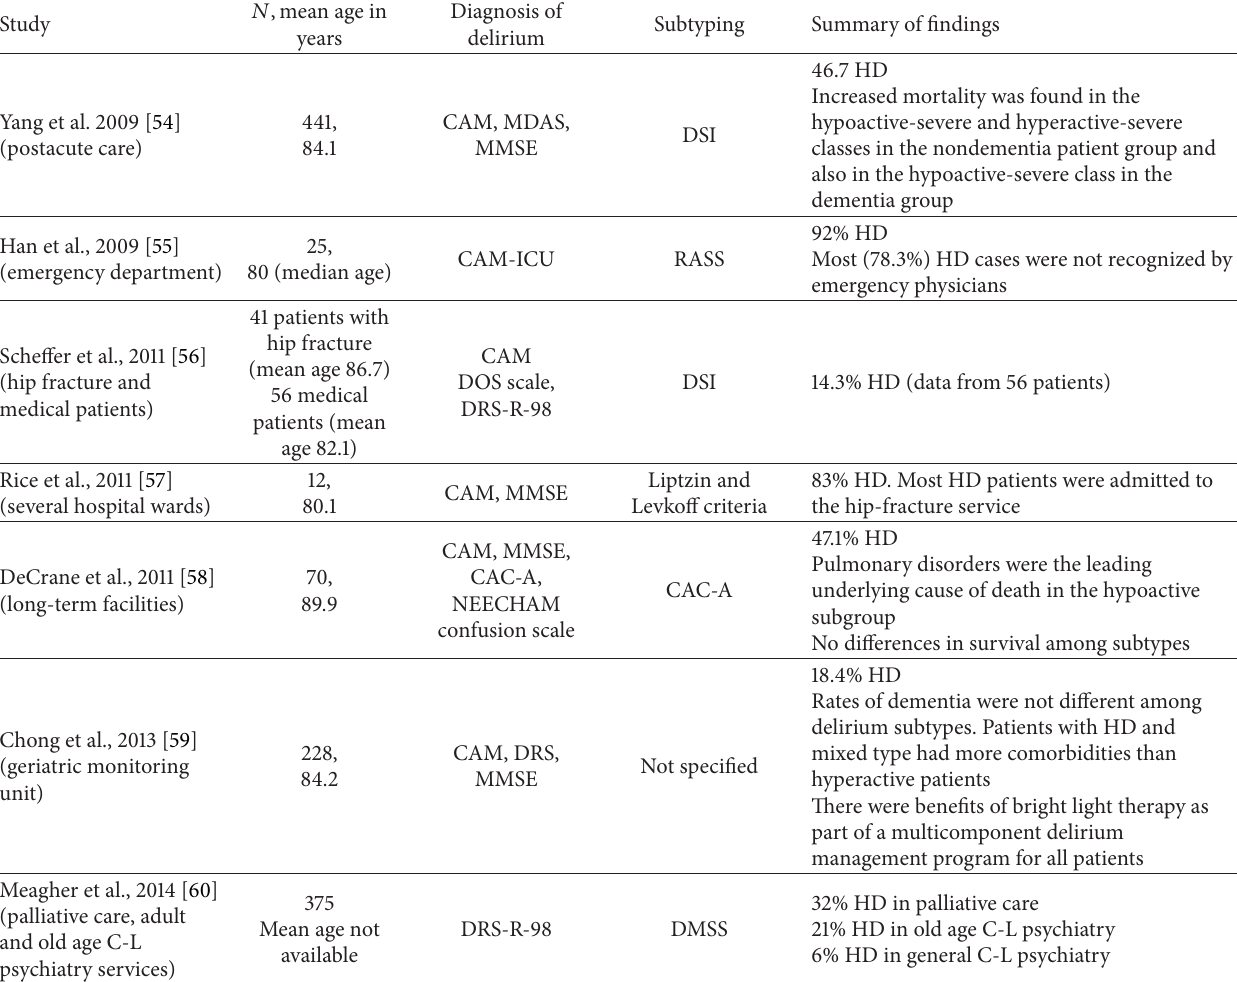
Table 7: HD in other